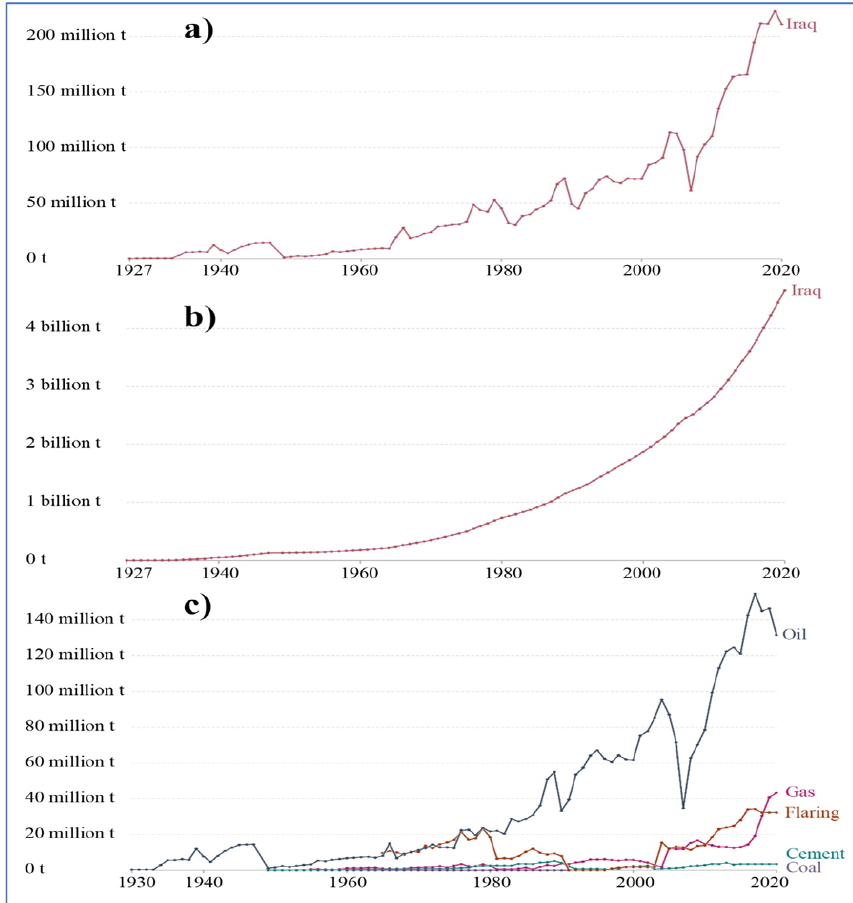
Figure 3. The annual mean temperature in Iraq for 1960 – 2020.